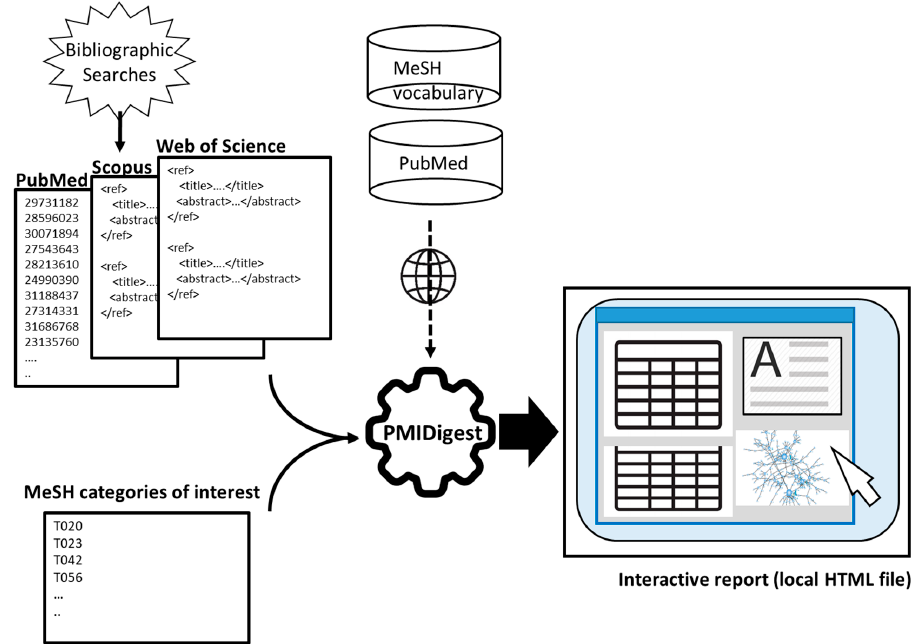
Figure 1. PMIDigest work fl ow for generating an interactive web report. The user input is shown on the left: sets of articles from PubMed, WoS, Scopus, or other resources (for example, from bibliographic searches), together with the MeSH categories of interest. This input, together with information retrieved automatically from PubMed and MeSH, is used to generate the interactive web report as a local HTML fi le.